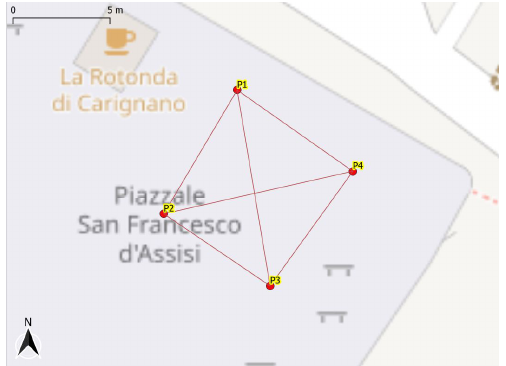
Figure 1. Trajectory used for test